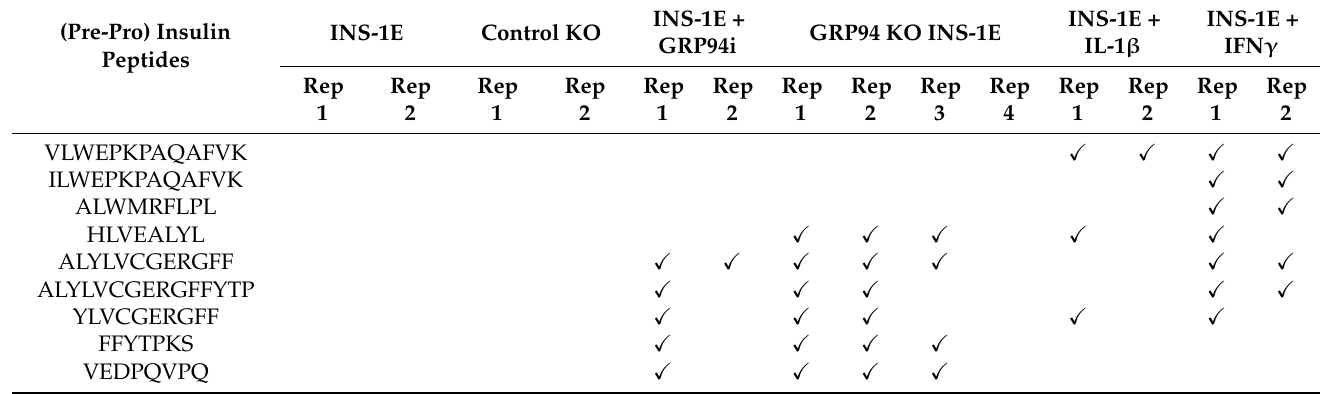
Figure 6. Decamers binding motif for INS-1E under tested conditions. ( A ) Parental INS-1E, ( B ) control GRP94 KO clone, ( C ) INS-1E treated with GRP94 inhibitor (20 µM for 24 h), ( D ) GRP94 KO INS-1E clone, ( E ) IL-1 β exposure (15 pg/mL for 24 h), and ( F ) IFN γ exposure (10 ng/mL for 24 h). N = 2 for all except GRP94 KO where N = 4. Table 1. RT1.A eluted proinsulin peptides from INS-1E cells derived from (pre)-proinsulin overlap- ping or unique for GRP94 KO/KD or cytokines exposure. ‘ (cid:88) ’refers to the presence of peptide in the group whereas empty column indicates absence of the peptides in the specific group. n = 2 for all groups except GRP94 KO where n =